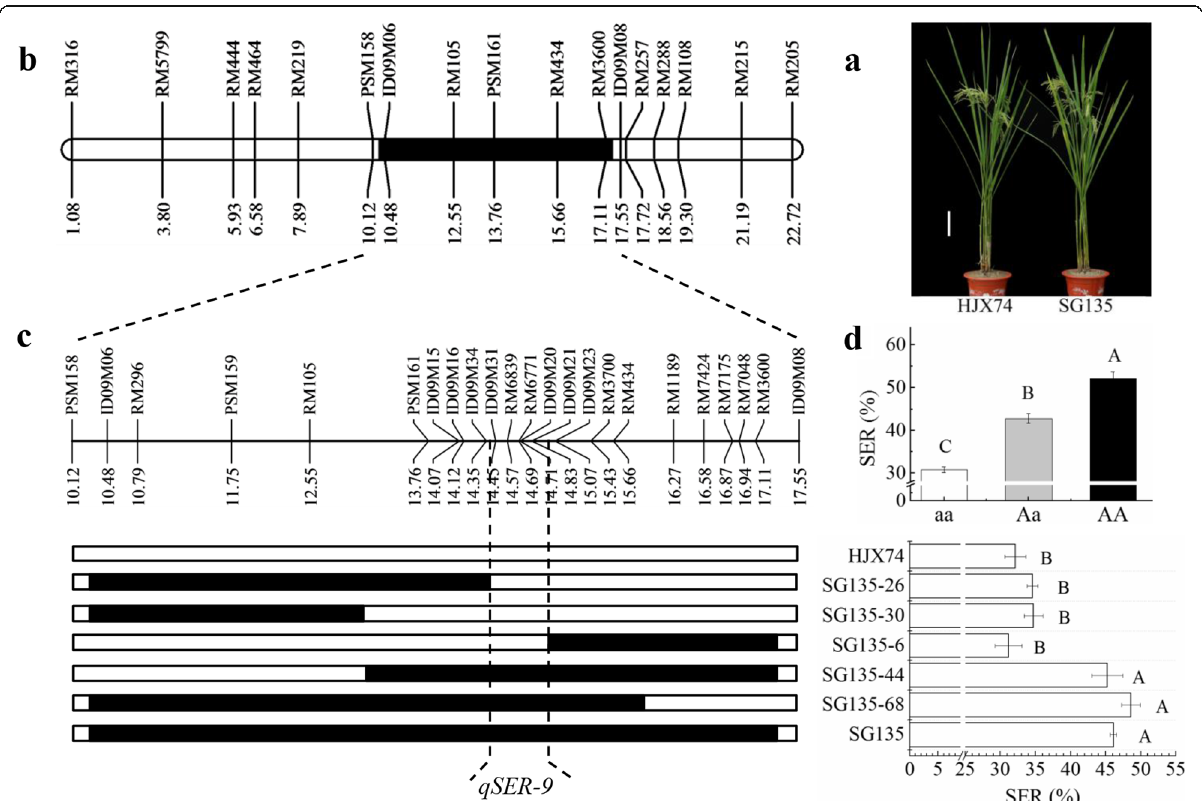
Fig. 4 Secondary substitution mapping of qSER-9 . a , Plant type of HJX74 and SG135. Scale bar, 15 cm. b , The substituted segment of SG135 on chromosome 9. c , Substitution mapping of qSER-9 , showing position of substituted segments and stigma exsertion rate (SER) of the SSSLs with HJX74 as the control. d , SER effects of three qSER-9 genotypes in a F 2 population. White and black blocks on chromosomes represent genotypes of HJX74 and donor, respectively. aa: Homozygous genotype of HJX74. Aa: Heterozygous genotype of SG135/HJX74. AA: homozygous genotype of SG135. Threshold, α = 0.001, one-way ANOVA, Duncan,